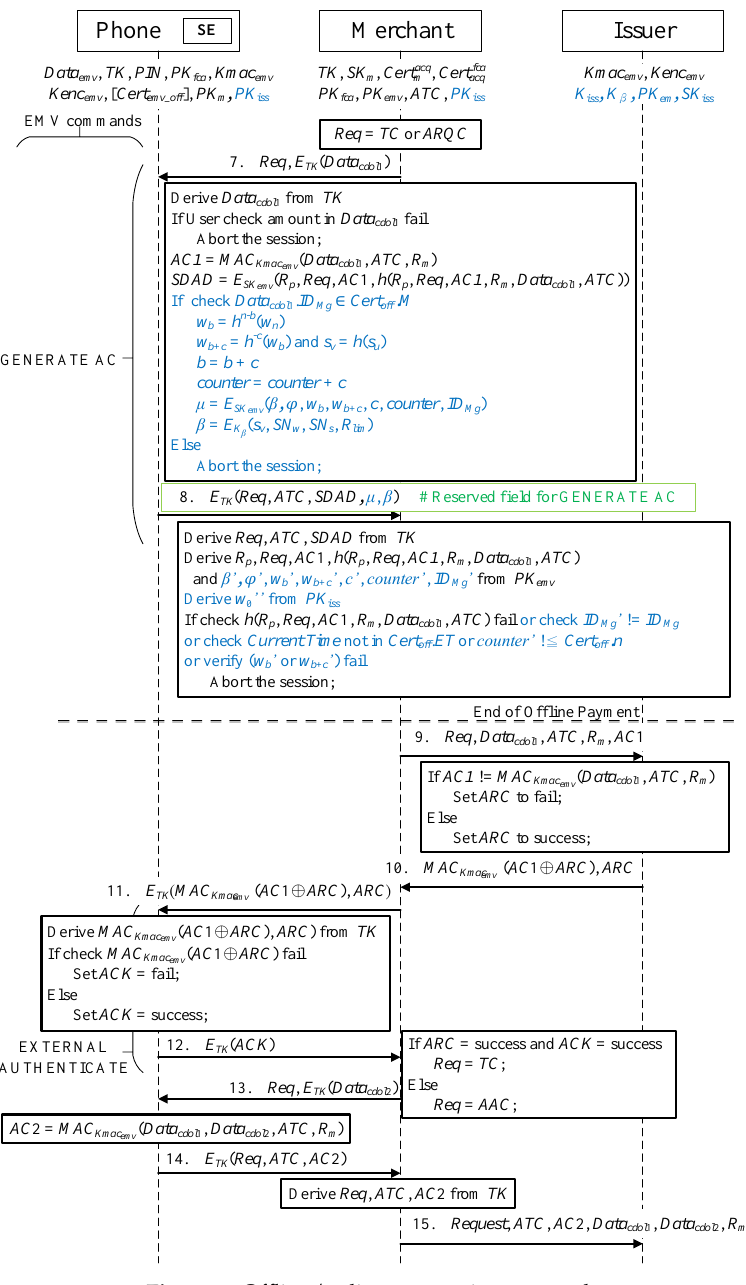
Figure 7. Offline/online transaction